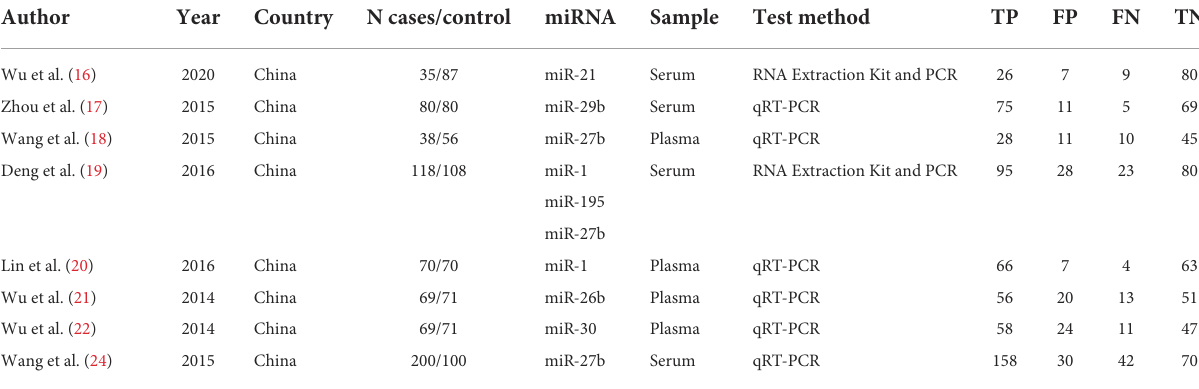
TABLE 1 The characteristics of the included studies.